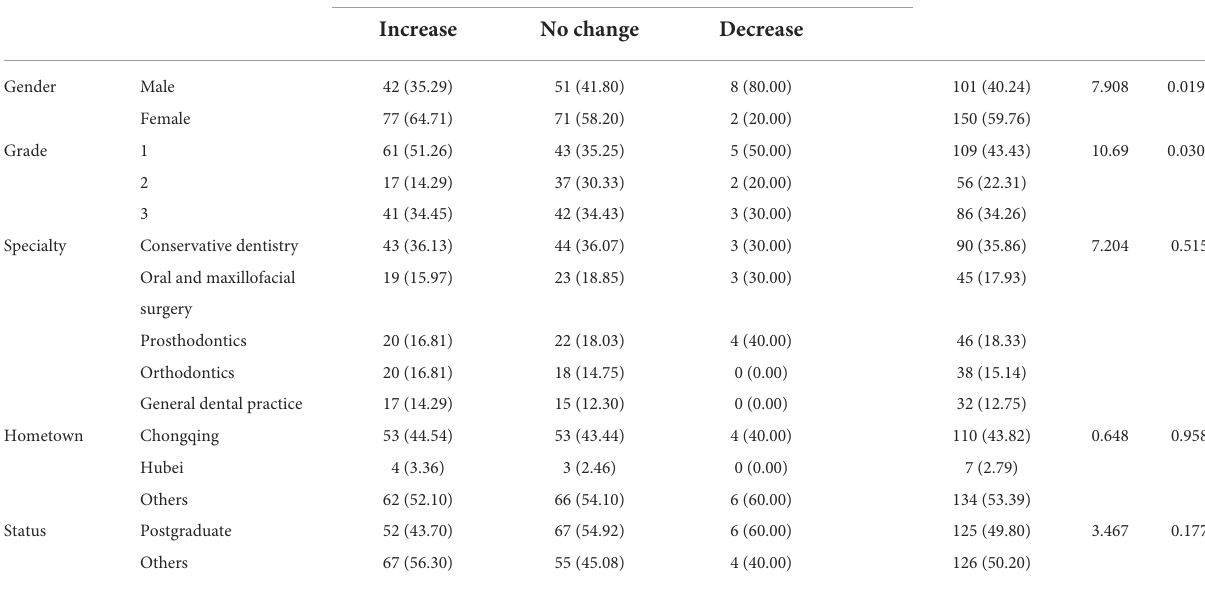
TABLE 4 The test score of infection control training